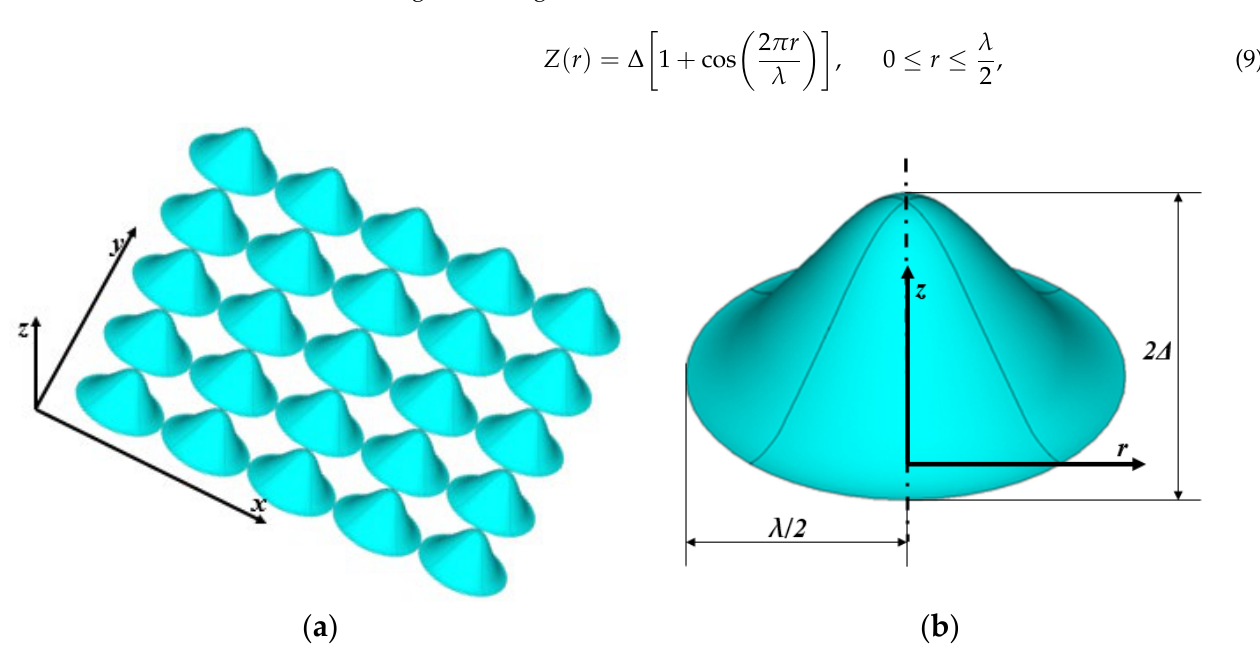
Figure 4. Schematic diagram of axisymmetric sinusoidal micro-convex surface for rough surface model. ( a ) Three-dimensional morphology; ( b ) single micro-convex body. Combined with the principle of equivalent simulation in contact mechanics [30], the microscopic contact between the two rough surfaces is equivalent to the contact between the axisymmetric sinusoidal micro-convex surface with the equivalent elastic modulus E